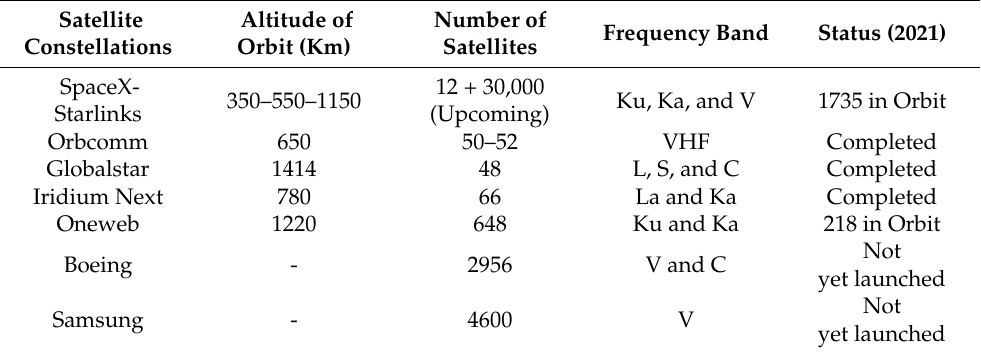
Figure 36. Geometry of sensor and target location in 3D using absolute and differential SOP process- ing from multiple LEO constellations. Table 7. Basic information on satellite formation, satellite constellations, principles, satellite altitude, frequency bands, and most popular LEO sat. status of the